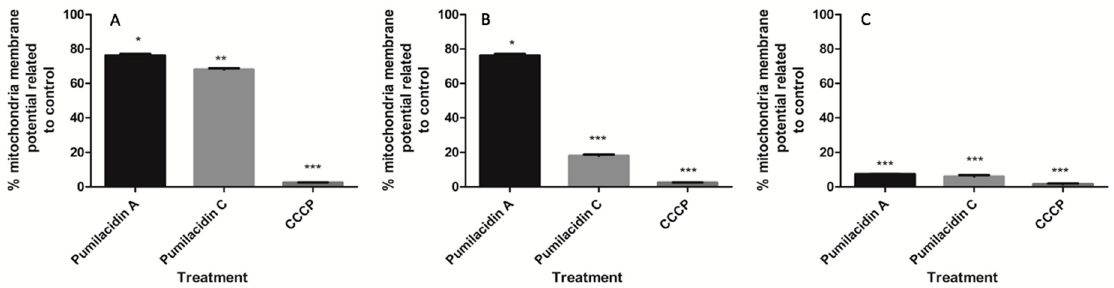
Figure 7. Mitochondrial membrane potentials. Changes in the mitochondrial membrane potentials relative to their untreated controls were measured with the mitochondrial potential-dependent dye DiO6 using flow cytometry after 3 h ( A ), 6 h ( B ), and 9 h ( C ) post treatment with pumilacidins A and C at 10 μ M in the schizont stage of the parasites. * p < 0.05; ** p < 0.01; *** p < 0.001.